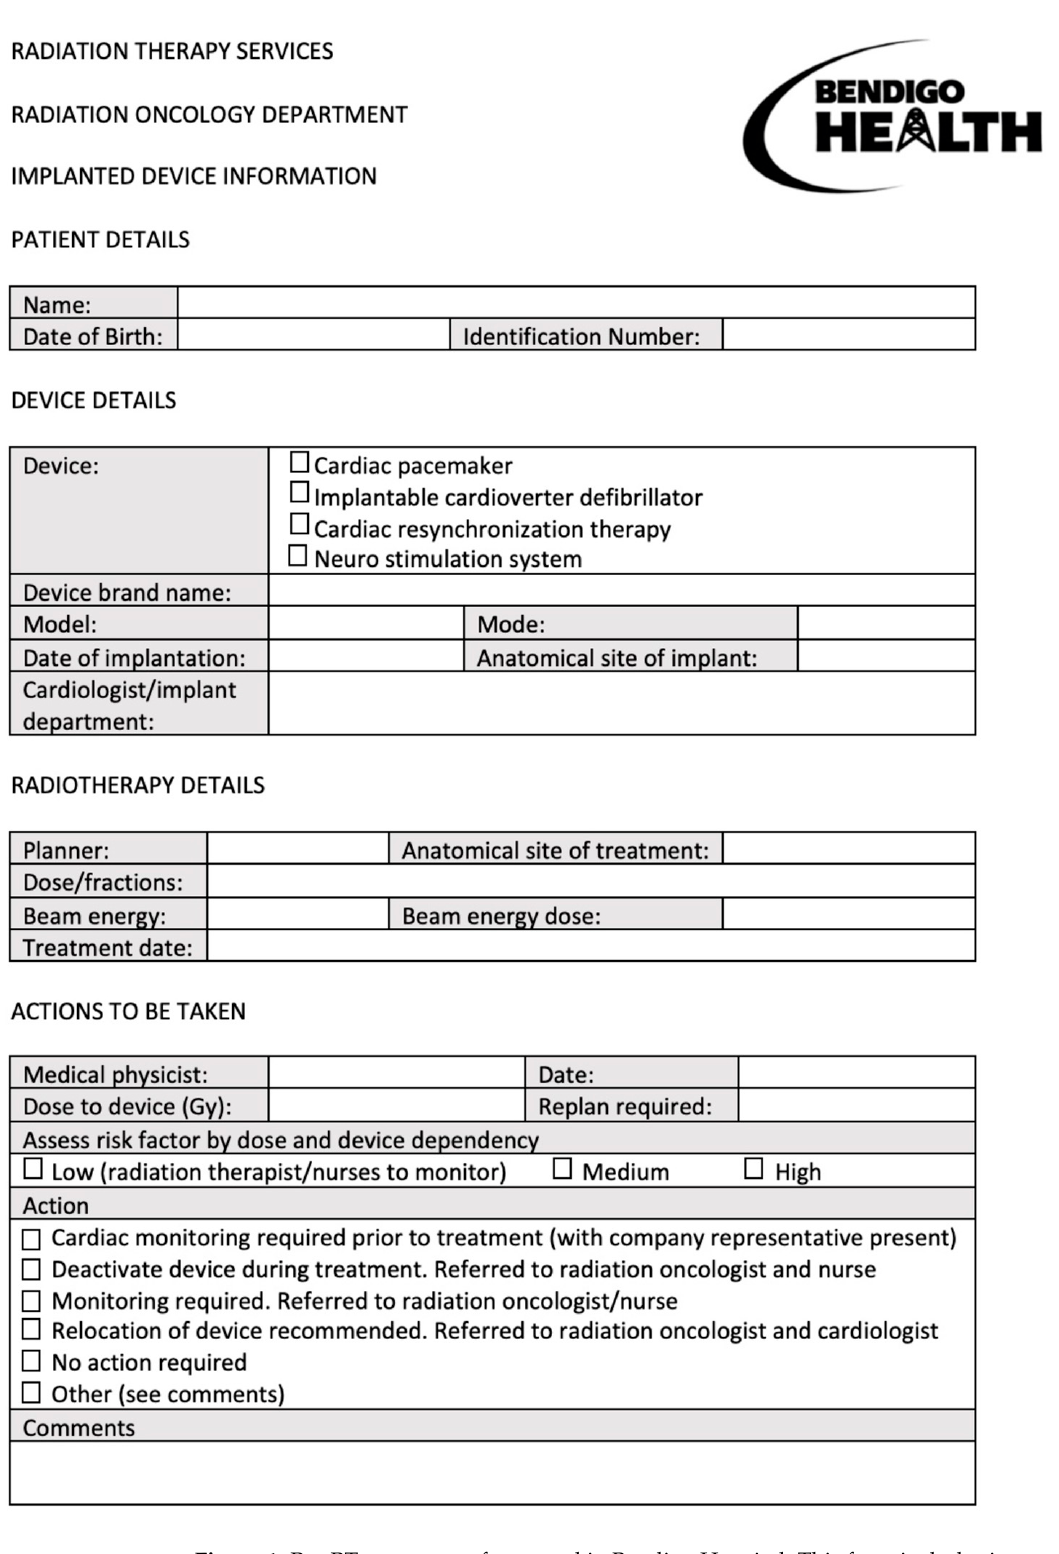
Figure 1. Pre-RT assessment form used in Bendigo Hospital. This form includes important informa- tion, such as details of CIED (device type, brand, mode, and site of implant) and RT (anatomical site of treatment, dose/fractions, dose to device, beam energy, and beam energy dose). This form concludes with a recommendation from the medical physicist, after evaluation of the CIED malfunction risk from the RT